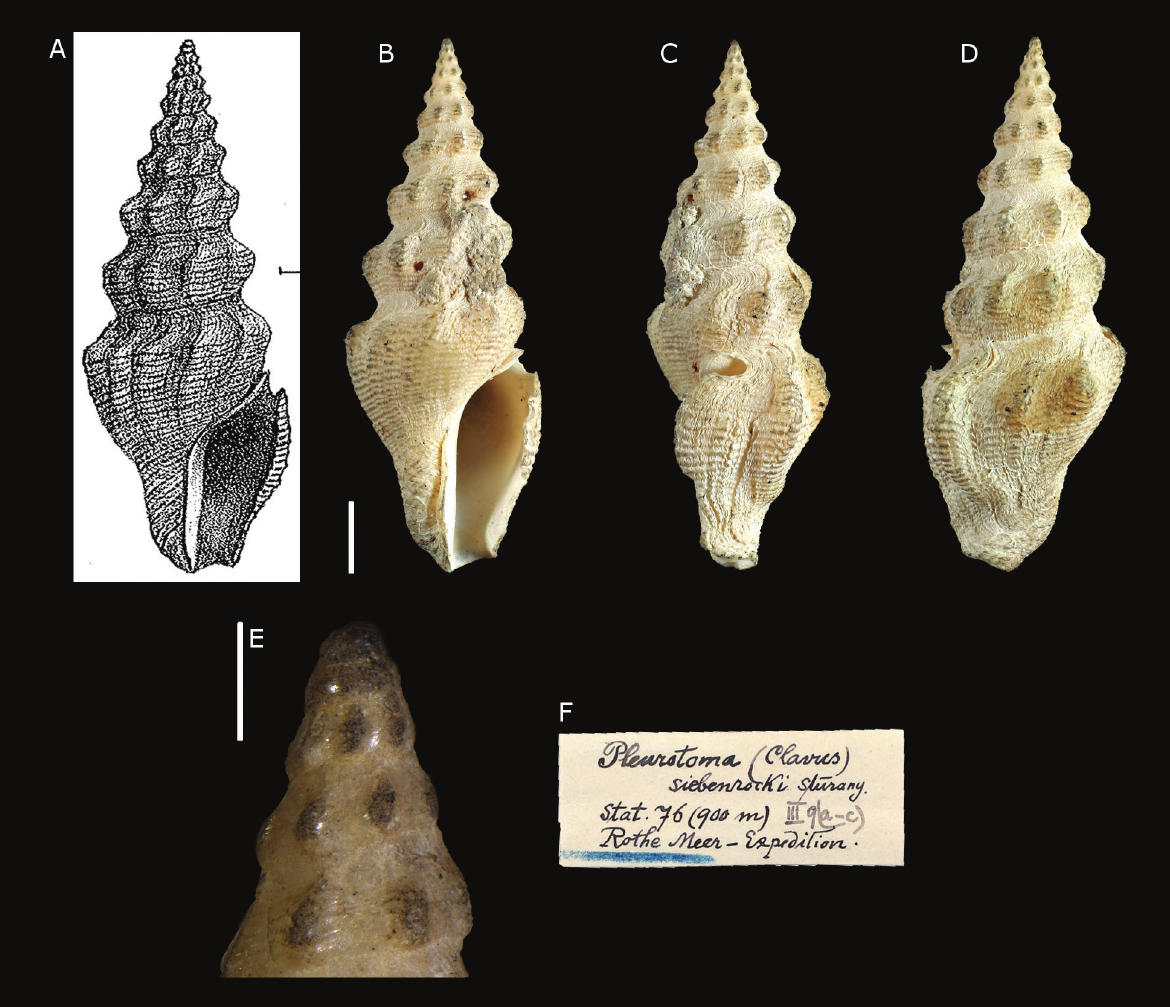
Figure 23. Pleurotoma siebenrocki Sturany, 1900, Station 76 (Sanafir Island, Strait of Tiran, Red Sea). A . Original figure by Sturany (1903). B–E . Holotype, NHMW 84252: front ( B ), right side ( C ), back ( D ), protoconch ( E ). F . Original holotype label. Scale bars: B–D : 5 mm, E : 1 mm.